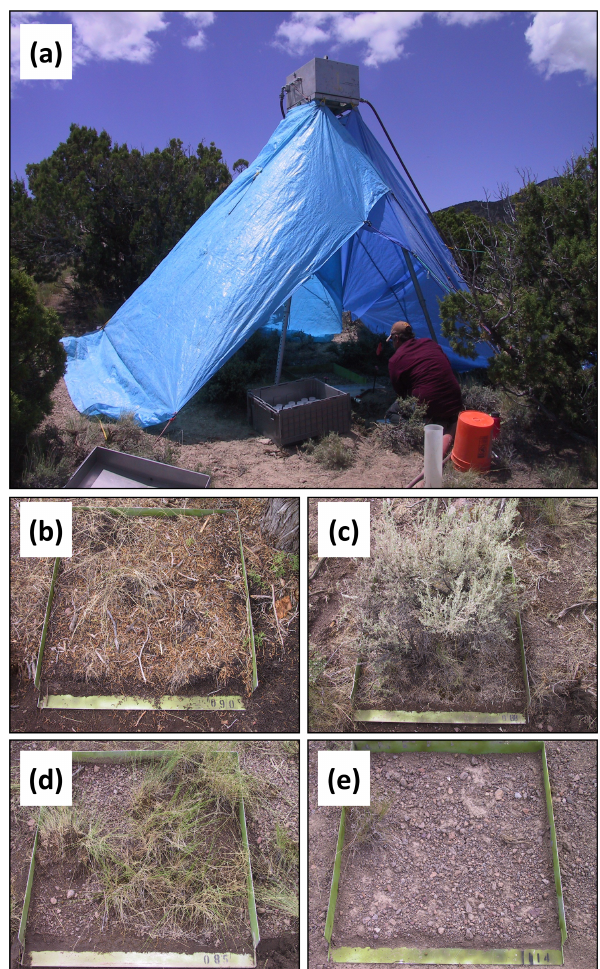
Figure 1. Photographs of small-plot rainfall simulator (a) and ex- ample small rainfall plots on tree coppice (b) , shrub coppice (c) , and interspace (d, e) microsites as applied in this